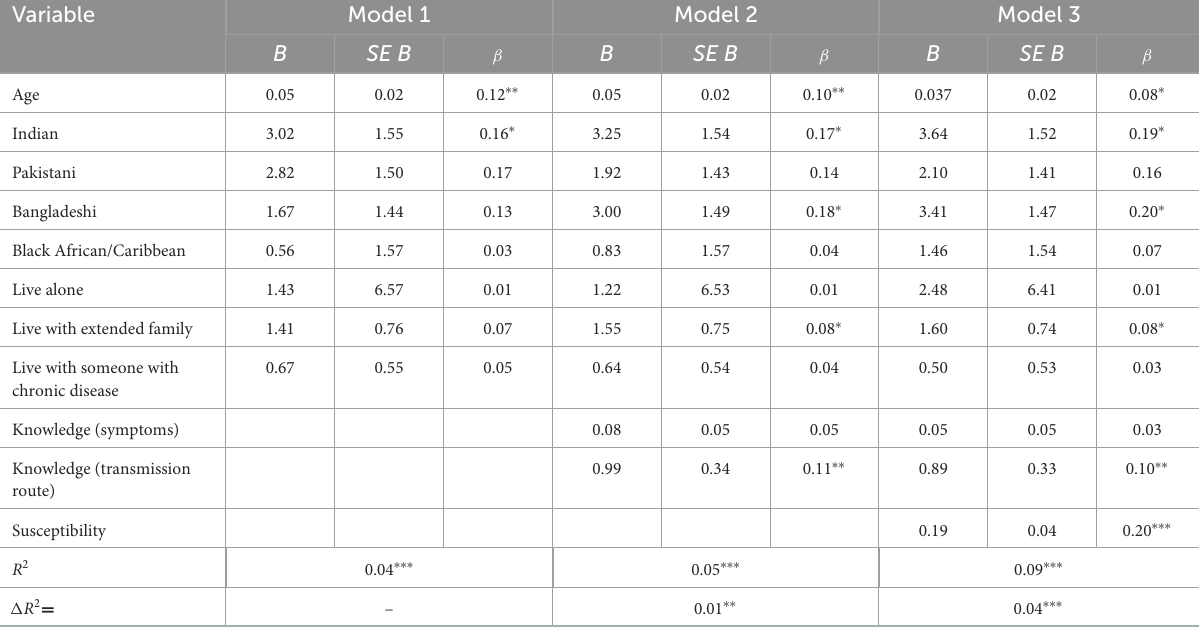
TABLE 9 Hierarchical regression of variables predicting attitudes toward COVID-19 protective